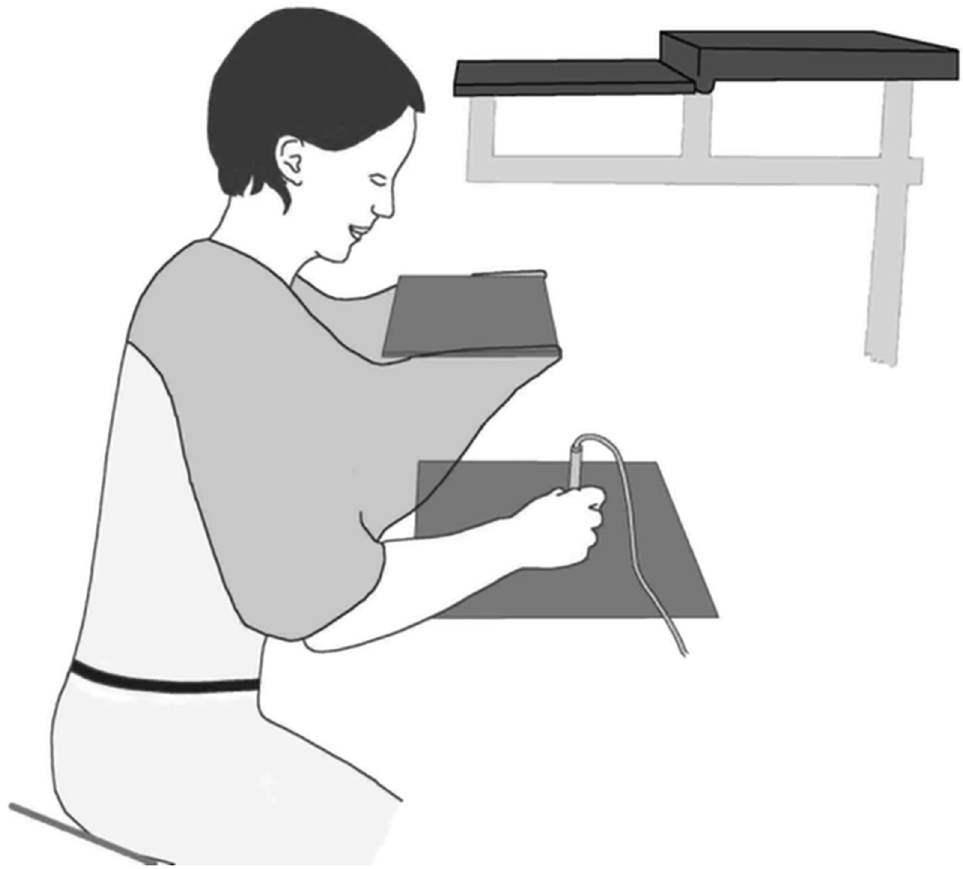
Fig 1. Scheme of experimental apparatus. Shown are tablet (T), screen (S) and mirror (M).